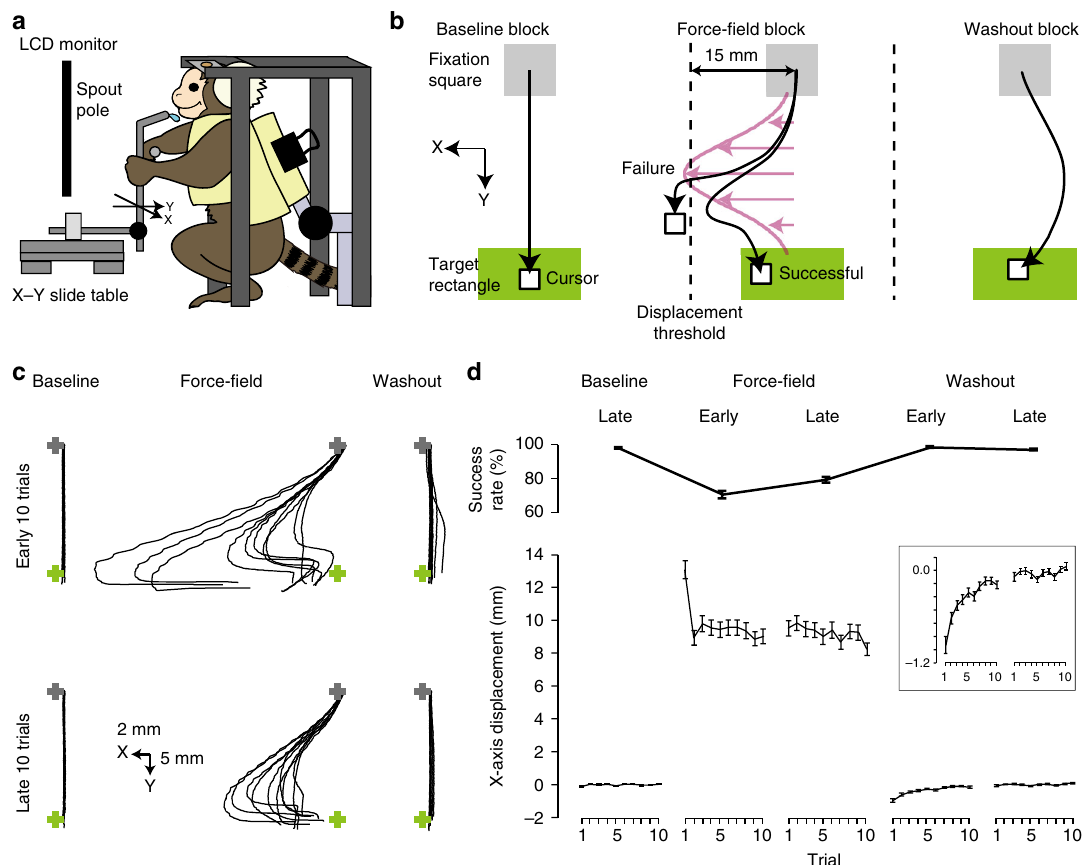
Fig. 5 Learning of the force- fi eld adaptation task. a Scheme of the task apparatus. In this task, the handling pole was replaced with the spout pole and the marmoset manipulated it to move the cursor on the monitor. A fi xed pole was put in front of the marmoset ’ s right arm to keep the right arm relaxed. b The target rectangle was placed below the fi xation square. The width of the target rectangle was twice its height. During the FF block, a velocity- (in Y-axis direction) dependent force fi eld was applied to the pole in the X-axis direction (representing the left direction in the hand workspace). c Example of the reaching trajectories in the fi rst baseline, fi rst force- fi eld, and fi rst washout blocks in session 2 from marmoset A. Gray and green crosses indicate the centers of the fi xation square and target rectangle, respectively. d Success rate averaged over ten trials (top) and X-axis displacement of each trial (bottom) in consecutive baseline, force- fi eld, and washout blocks ( n = 117 from three marmosets). The early and late trials were the fi rst ten and fi nal ten reaching trials in each block. Success rate was the percentage of successful trials out of the ten trials. In the inset, the X-axis displacement in the washout block is magni fi ed. Error bars indicate